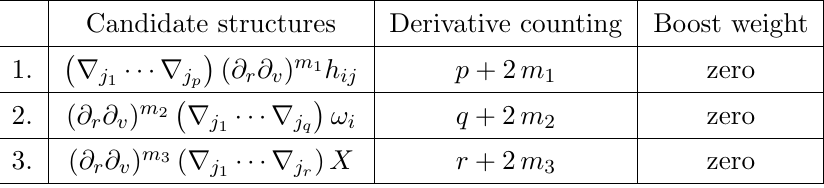
Table 3 . ‘Equilibrium’ and ‘boost-invariant’ structures built out of the basic building blocks.